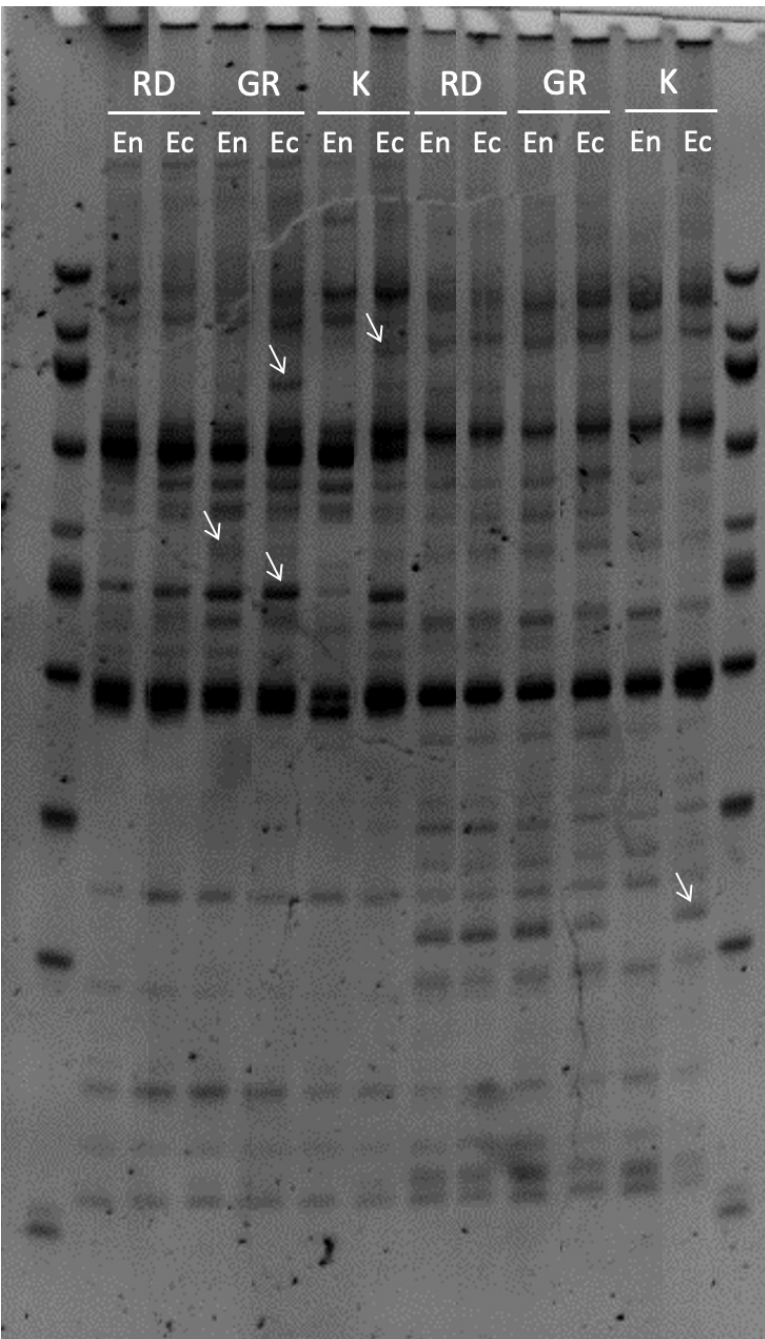
Figure 1. Representative gel image of MSAP analysis of polymorphic fragments observed among sweet cherry varieties Royal Dawn, Glen Red and Kordia, during ENDO and ECO stages. Lane 1 and 14: ladder; lanes 2 and 3: Royal Dawn, at ENDO and ECO stages, respectively, digested with EcoRI–HpaII; lanes 4 and 5: Glen Red, at ENDO and ECO stages, respectively, digested with EcoRI–HpaII; lanes 6 and 7: Kordia, at ENDO and ECO stages, respectively, digested with EcoRI–HpaII; lanes 8 and 9: Royal Dawn, at ENDO and ECO stages, respectively, digested with EcoRI–MspI; lanes 10 and 11: Glen Red, at ENDO and ECO stages, respectively, digested with EcoRI–MspI; lanes 12 and 13: Kordia, at ENDO and ECO stages, respectively, digested with EcoRI–MspI. The arrow marks indicate the presence of polymorphic fragments, obtained using the combination of selective primers ATA/TCG.